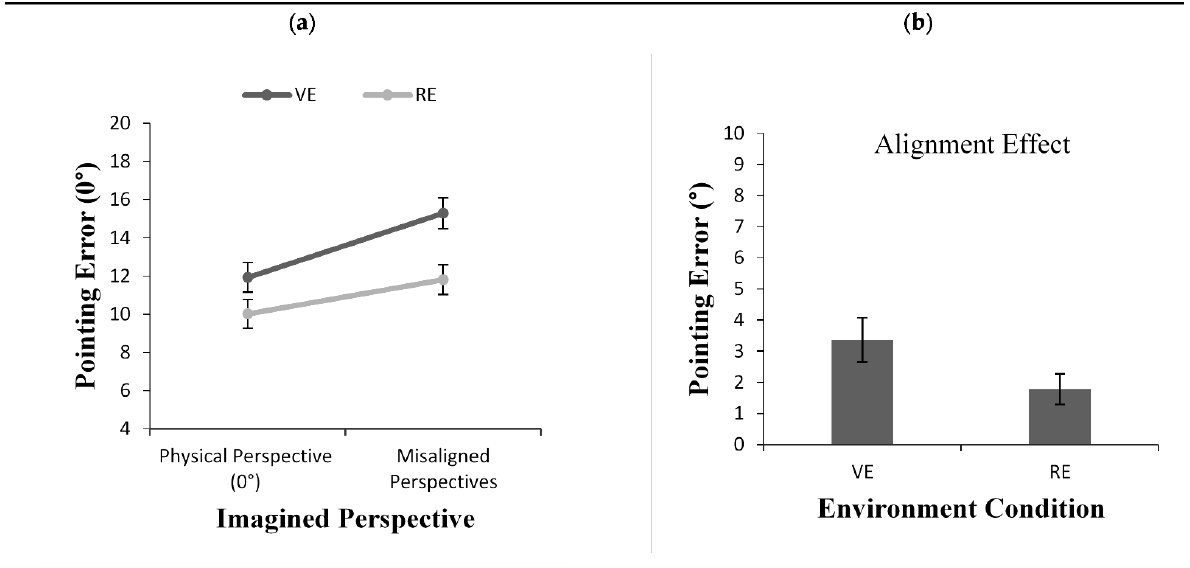
Figure 2. Pointing error ( a ) as a function of imagined perspective and alignment effect for pointing error ( b ) across environment conditions (VE vs. RE) in Experiment 1. Error bars represent standard errors from the ANOVA and from a t -test, respectively.